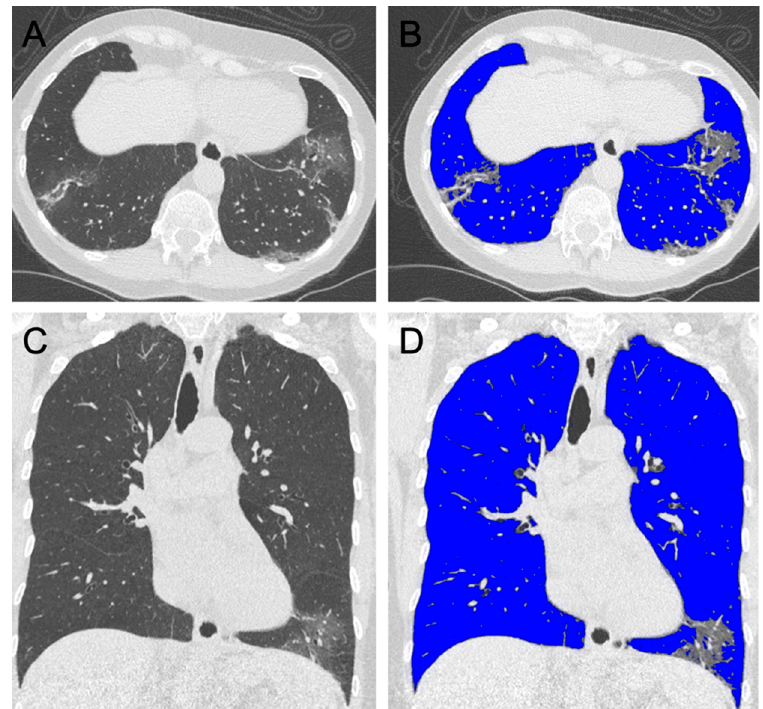
Figure 2. Axial ( A , B ) and coronal ( C , D ) reformations of the chest computed tomography (CT) of a 68-year-old female patient presenting with fever and cough. Radiological severity grade 3 was assigned. Lung volume quantification accounted for >90% ventilated volume (shaded blue in B and D).